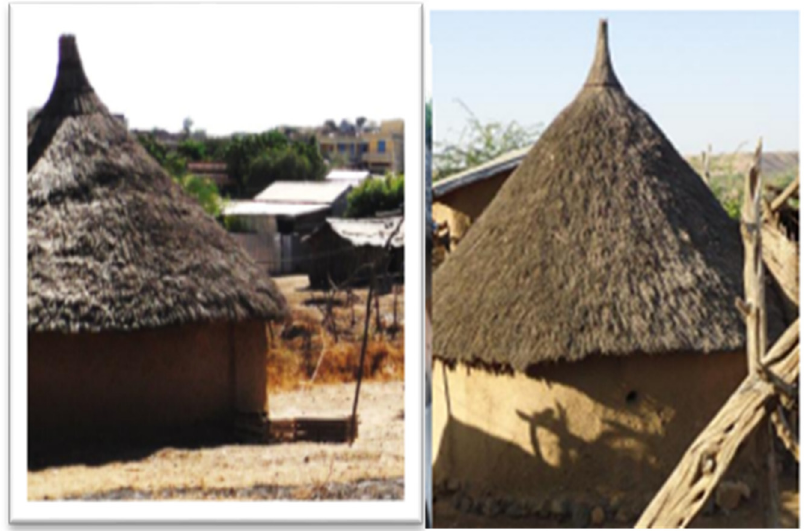
Figure 6. Roof shading. Figure 6. Roof